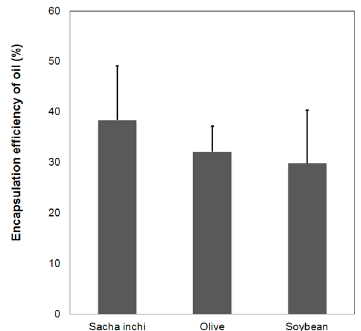
Figure 9. The oil encapsulation efficiency of AL-CS nanoemulsions prepared with different types of oil: sacha inchi, olive, and soybean (solution to oil ratio was fixed to 9:1).